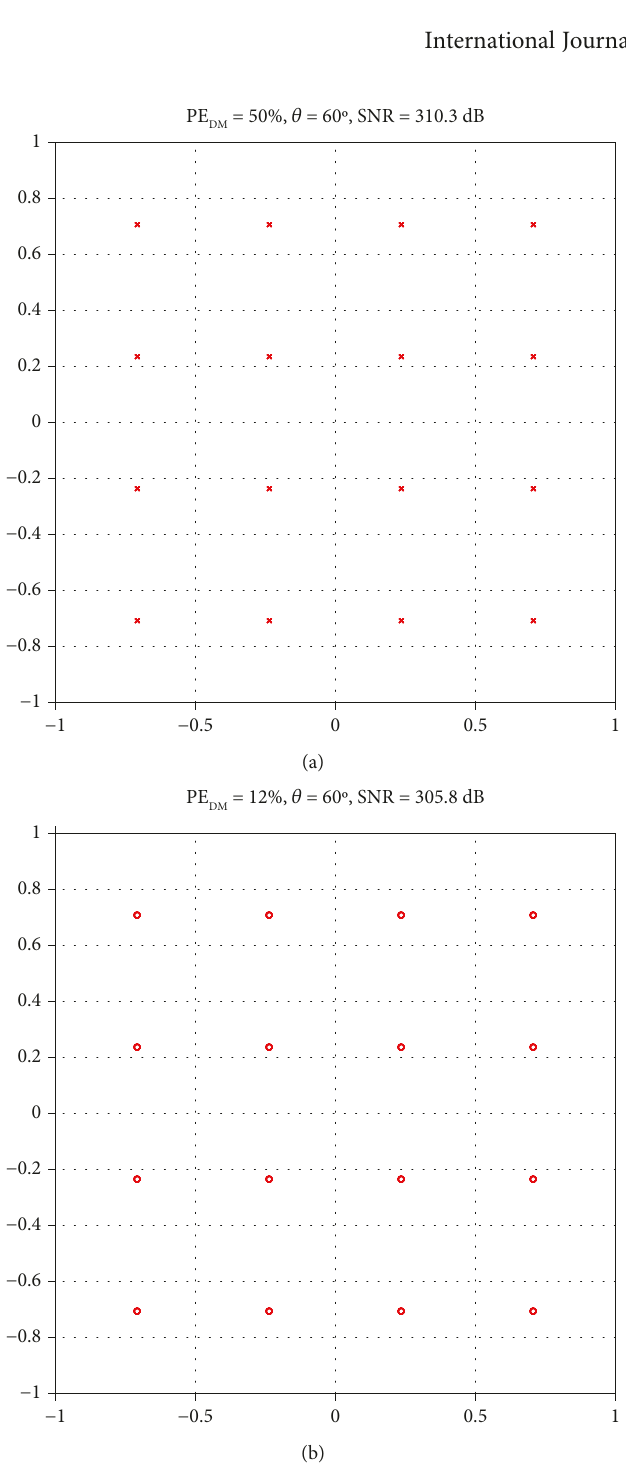
Figure 9: DDM 16-QAM modulation transmitted at the secure direction 60 ° using real components and (11) to compute S modulators. (a) PE DM = 50% . (b) PE DM = 12%